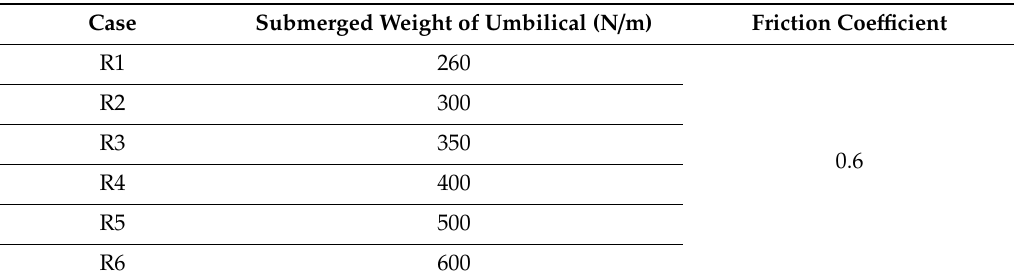
Table 7. The overview of analysis cases for